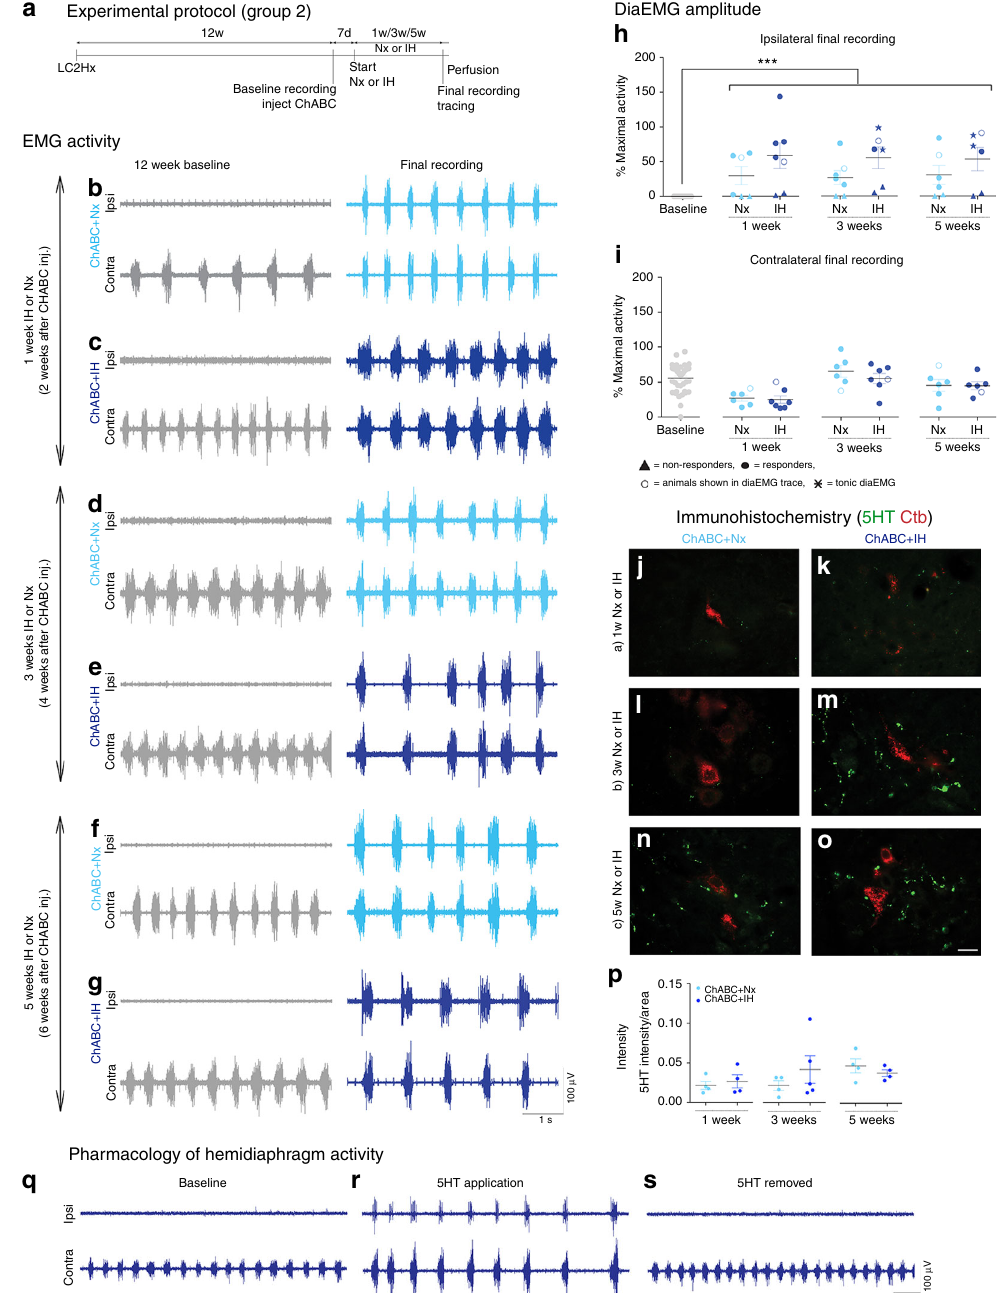
Fig. 2 Matrix remodelling recovers respiratory activity at multiple time points. a Experimental protocol. b – g DiaEMG recordings at baseline and following treatment. Animals received ChABC and air (Nx) or IH conditioning for b , c 1 week; d , e 3 weeks; or f , g 5 weeks. Data panels presented from the same animal ( n = 6/7). h , i Average amplitude of h ipsilateral and i contralateral diaEMG. Filled circles = responders; un fi lled circles = animals in b – g ; triangles = non-responders; stars = tonic activity shown. For b – i , n = 6/7 per group, baseline n = 38. j – p Immunohistochemistry and intensity readings at the ipsilateral C4 PMP utilizing Ctb (red) and 5HT (green; n = 4/5 per group). q – s Activity is present in the ipsilateral hemidiaphragm following application of exogenous 5HT ( n = 9). For all EMG or graph panels, treatment groups = baseline (grey); ChABC + air (light blue); ChABC + IH (blue). *** p < 0.001. If no post-hoc result is shown, comparison was not-signi fi cant. Scale bar = 50 μ m. For all panels: values represent mean ±